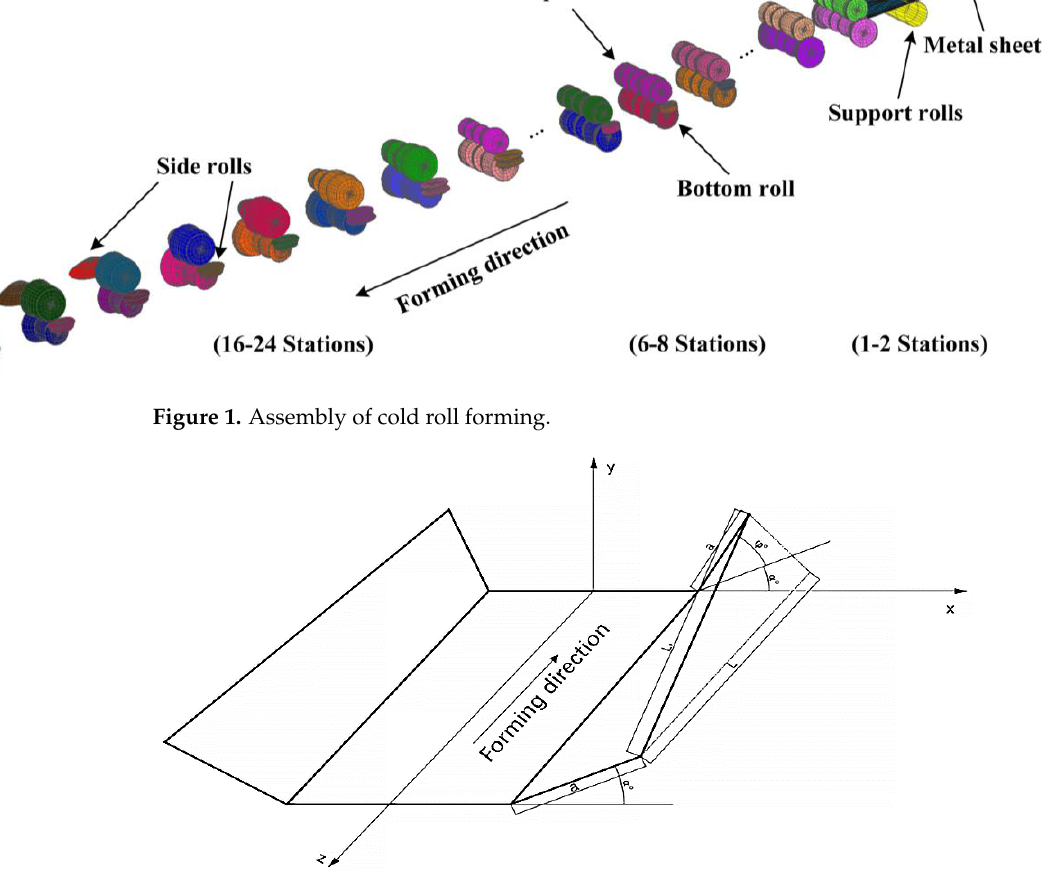
Figure 2. Flow of the metal strip.